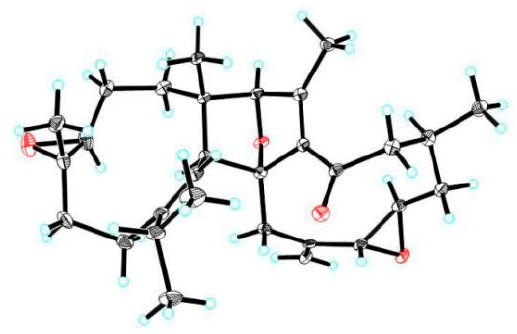
Figure 5. X-ray crystallographic structure of 2 .